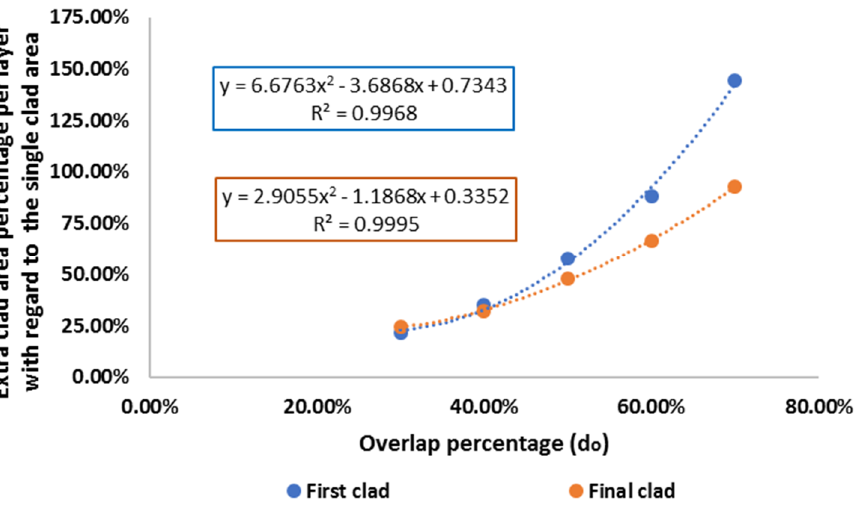
Figure 7. Representation of the extra clad area needed to compensate the lack of material on the edges of the coating as a function of the overlap percentage. Blue: area percentage needed in the first part of the coating; orange: area percentage needed in the final part of the coating. Data obtained from the coating model described in Section 2.1.1. for vertically deposited Alloy 718 at 2500 W, 18 g·min −1 , and 500 mm·min −1 .